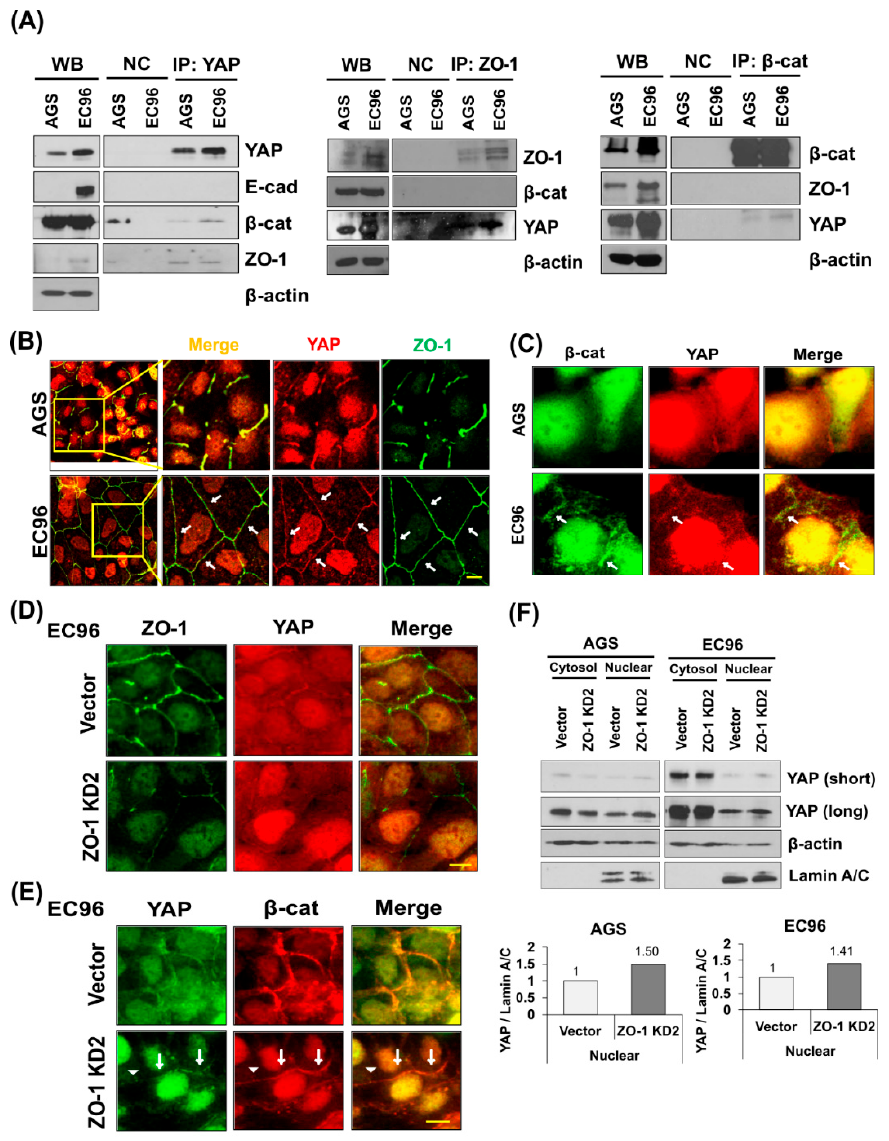
Figure 3. YAP is associated with ZO-1 at TJs. ( A ) IP was performed on AGS and EC96 cell lysates using anti-YAP, -ZO-1, or - β -catenin antibodies. Precipitates were subjected to immunoblot analysis using the indicated antibodies. ( B , C ) AGS and EC96 cells were subjected to IF analysis to evaluate the interaction between YAP and ZO-1 ( B ), or YAP and β -catenin ( C ). Arrows indicated regions of colocalization. Scale bar = 10 µ m. ( D , E ) EC96 ZO-1 KD cells were subjected to IF analysis to evaluate the interaction between YAP and ZO-1 ( D ), or YAP and β -catenin ( E ). Arrows indicated regions of colocalization. Arrowheads indicated regions of non-colocalization. Scale bar = 10 µ m. ( F ) EC96 ZO-1 KD cells were subjected to subcellular fractionation analyses to evaluate nuclear YAP expression. Short and long exposures of the blot are shown. Densitometry analyses were performed to evaluate the YAP/Lamin A/C ratio in AGS and EC96 cells.